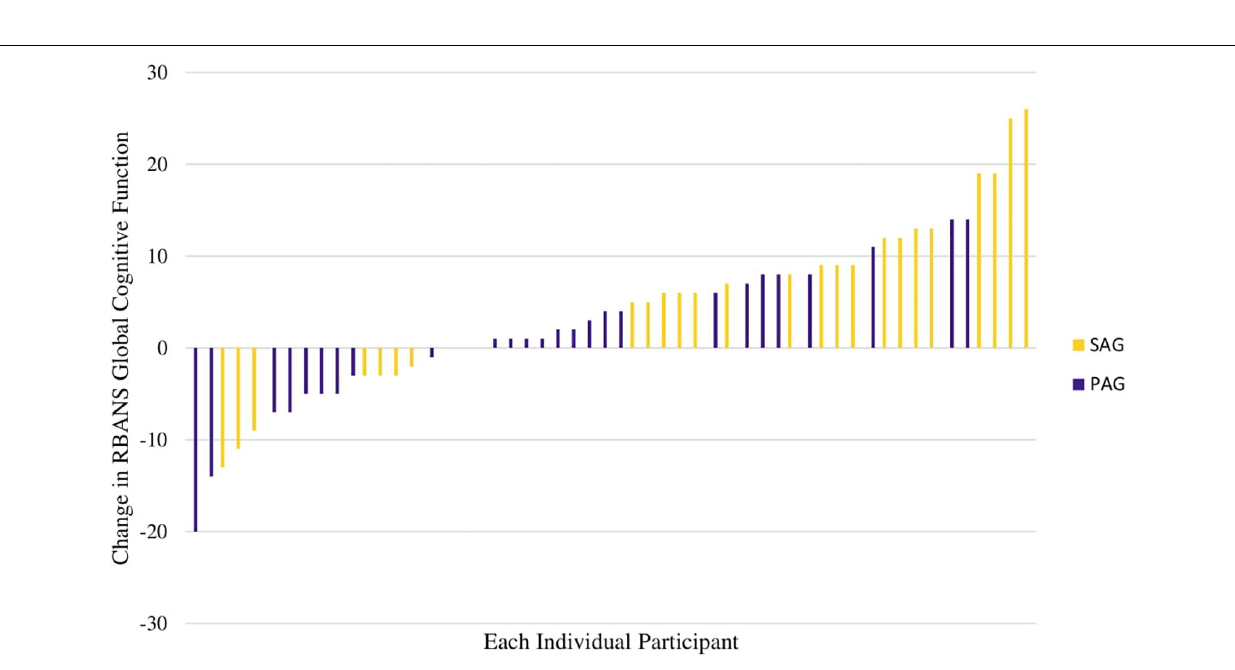
Frontiers in Aging Neuroscience |